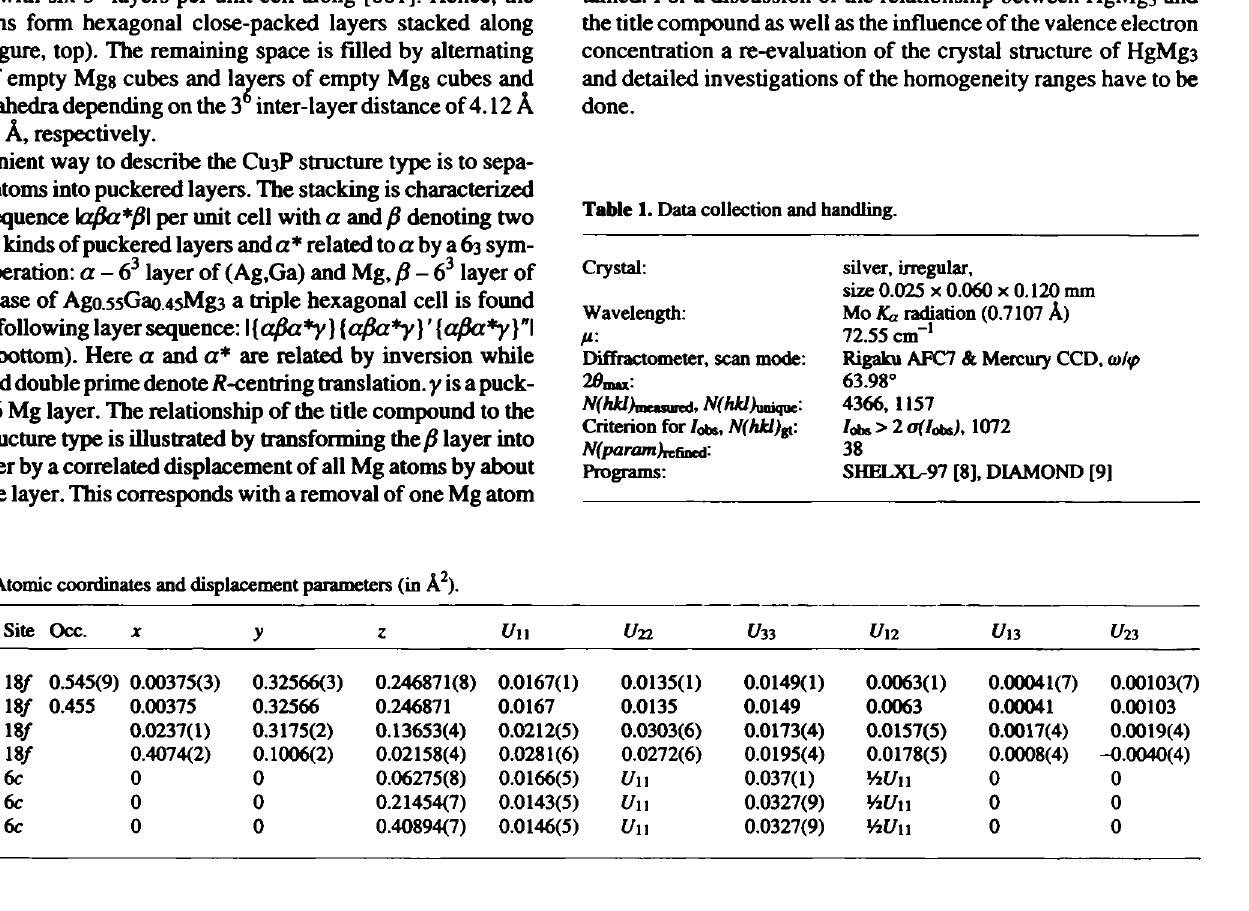
Table 2. Atomic coordinates and displacement parameters (in A 2